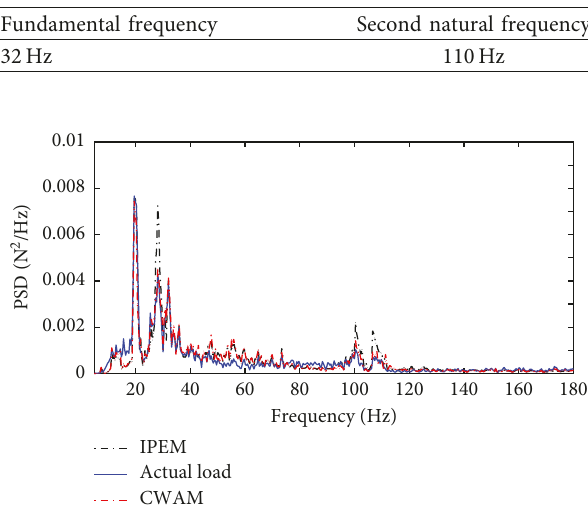
Table 11: Natural frequencies of the thermal protection composite plate.